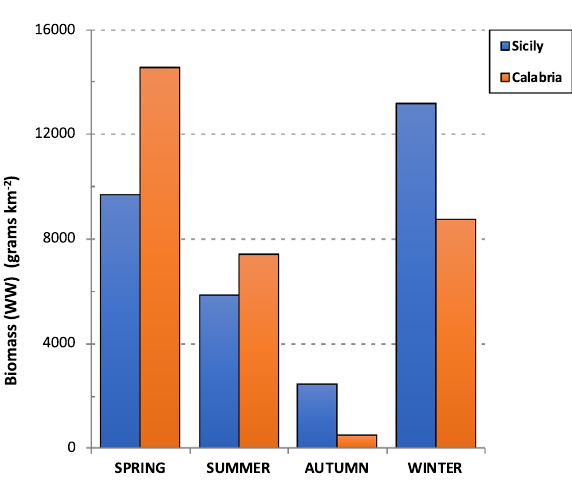
Figure 9. Seasonal trend of cumulated biomass of P. noctiluca stranded specimens along the coasts of Sicily (4 sites) and Calabria (3 sites) from March 2015 to February